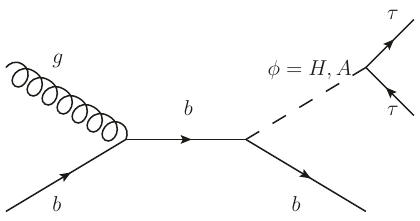
Figure 3 . Feynman diagram of the production of (cid:30) in association with a bottom quark at LHC, with a subsequent decay into (cid:28)(cid:28) pair.